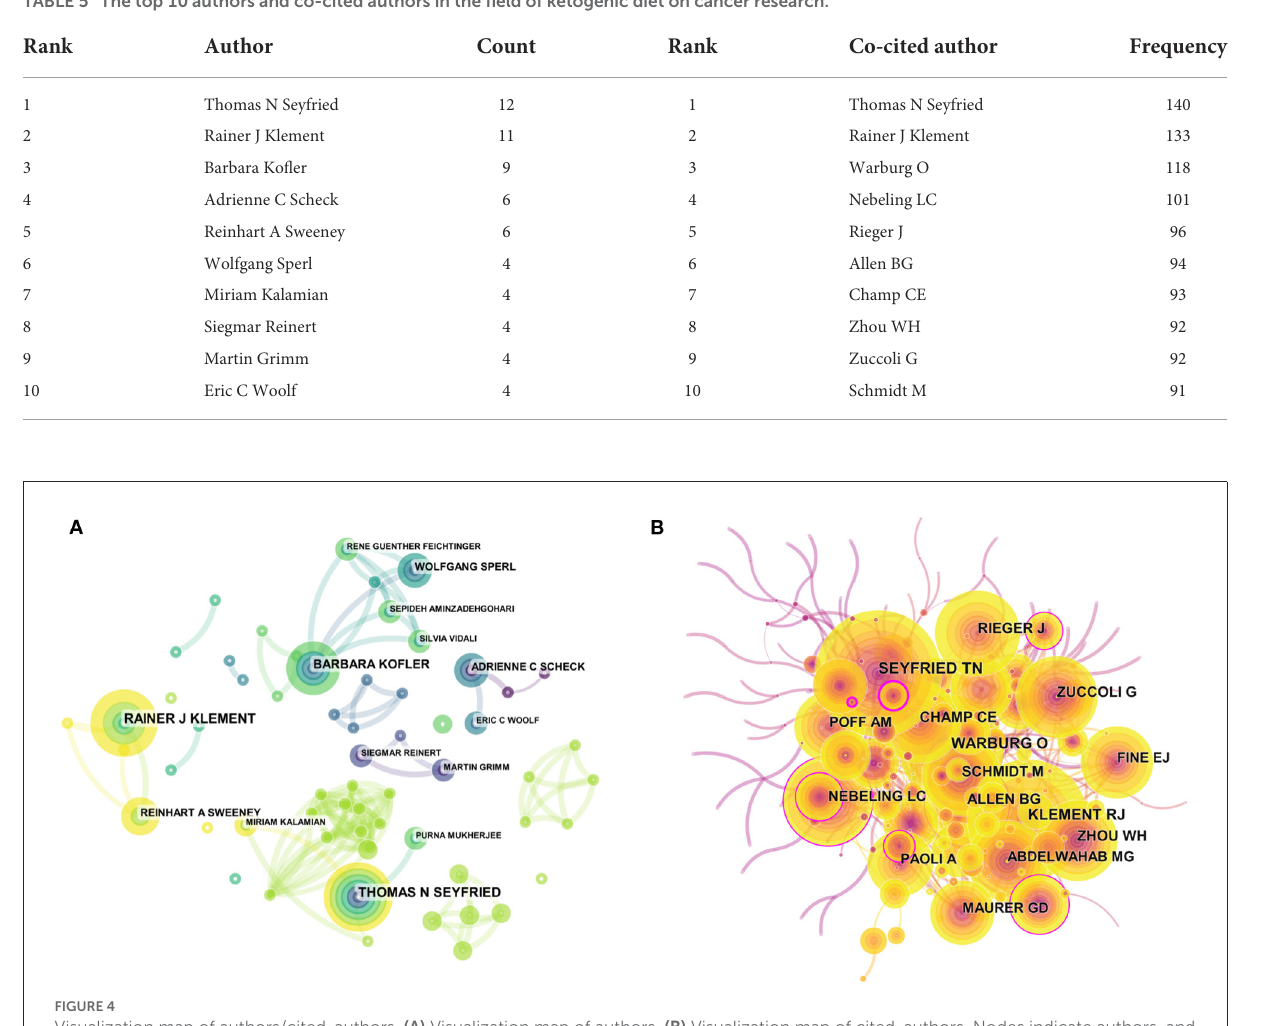
TABLE 5 The top 10 authors and co-cited authors in the field of ketogenic diet on cancer research.